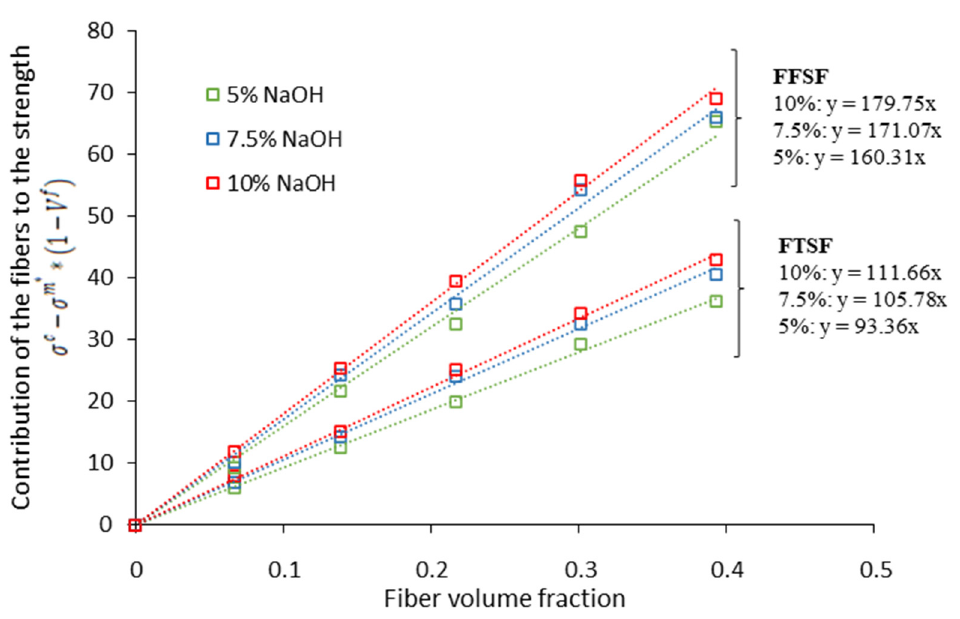
Figure 7. Contribution of the fiber to the composite’s strength at different fiber content.